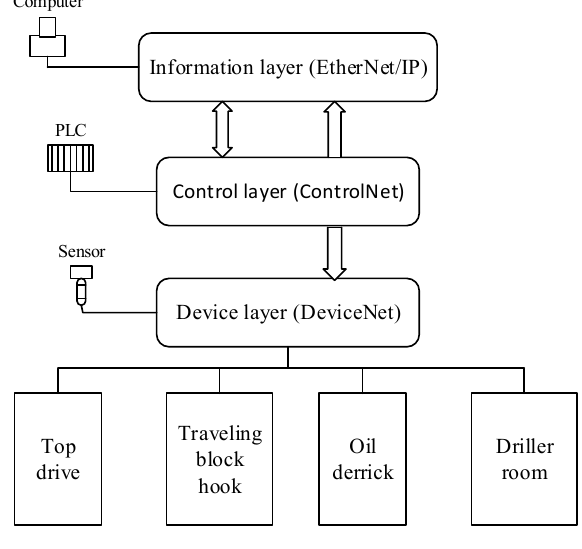
Figure 2. Netwok diagram of whole system.